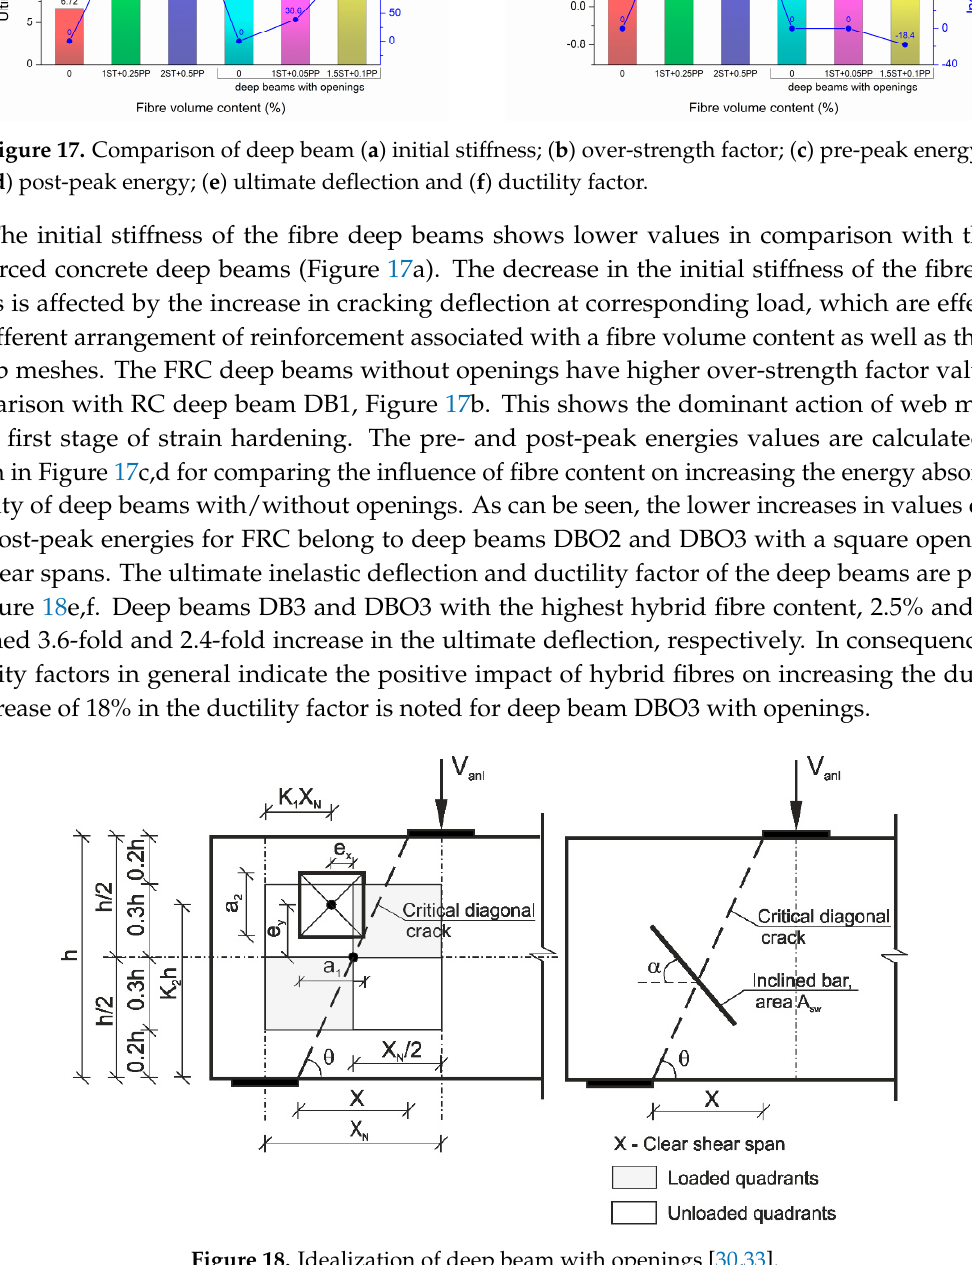
Figure 18. Idealization of deep beam with openings [30,33].